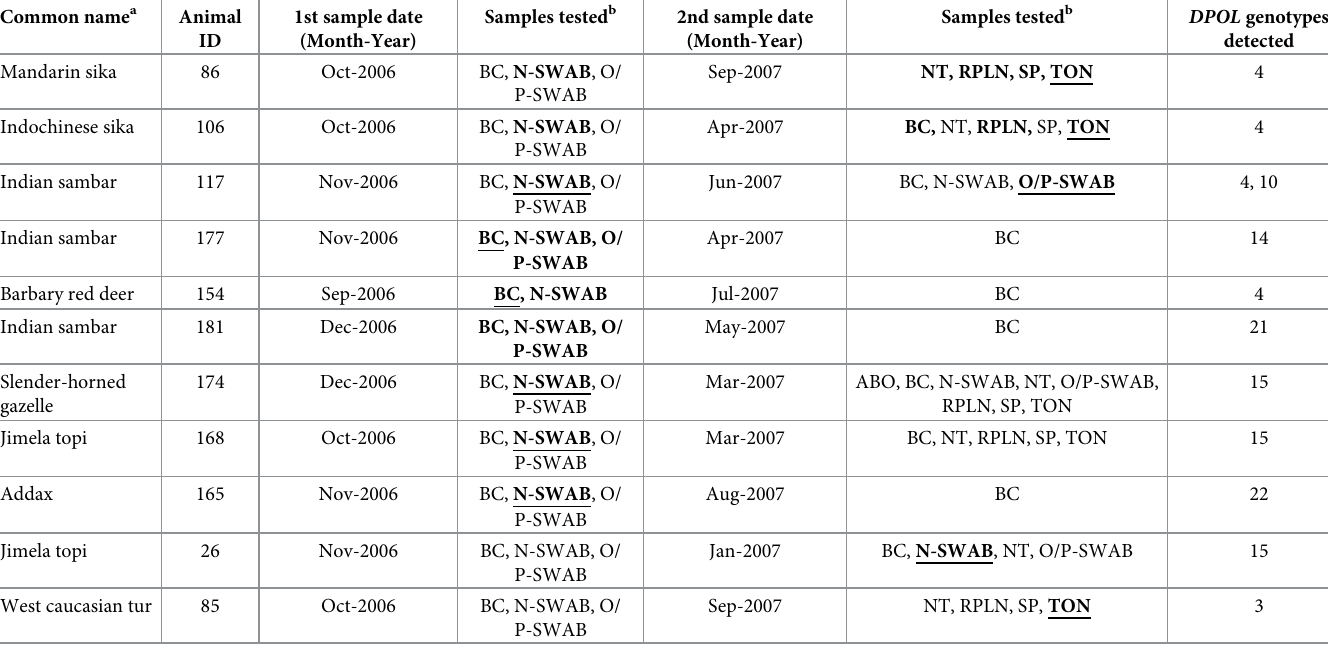
Table 2. Individual animals positive for herpesviruses and sampled at multiple time